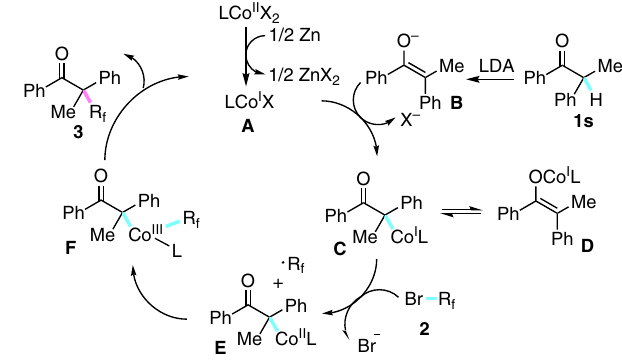
Fig. 5 Proposed mechanism. The possible reaction pathway based on our studies and the previous literatures which was in situ generated with the assistance of LDA, afforded the corresponding Co(I) complex C and D . A single electron oxidation of Co(I) C by fl uoroalkylating reagent 2 generated the corresponding radical and Co(II) species, which was further transformed to Co(III) intermediate F after the following radical oxidation. At last, the reductive elimination of F furnished the fi nal product 3 and regenerated Co(I) species to enter the next catalytic circle.